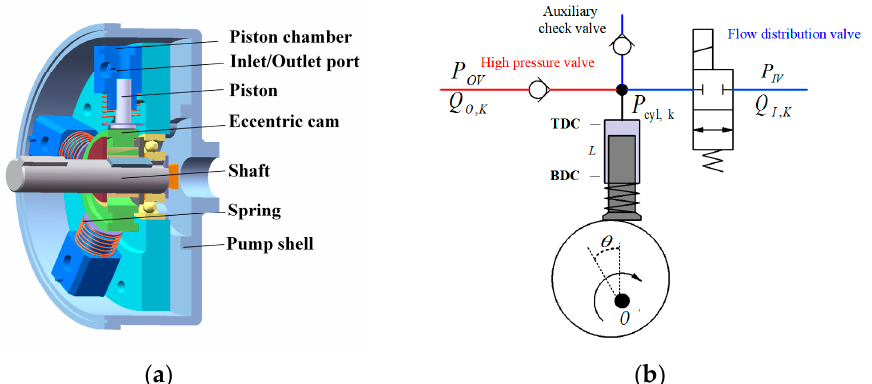
Figure 1. Structure and working principle: ( a ) Structural section drawing; ( b ) flow distribution principle.